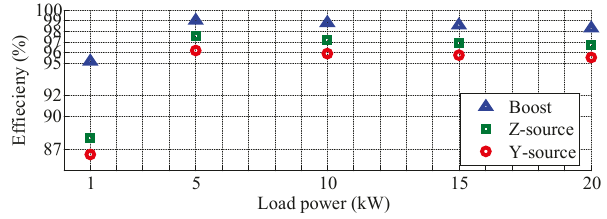
Fig. 8. The efficiency at different loading power and using a volatge gain of 2.